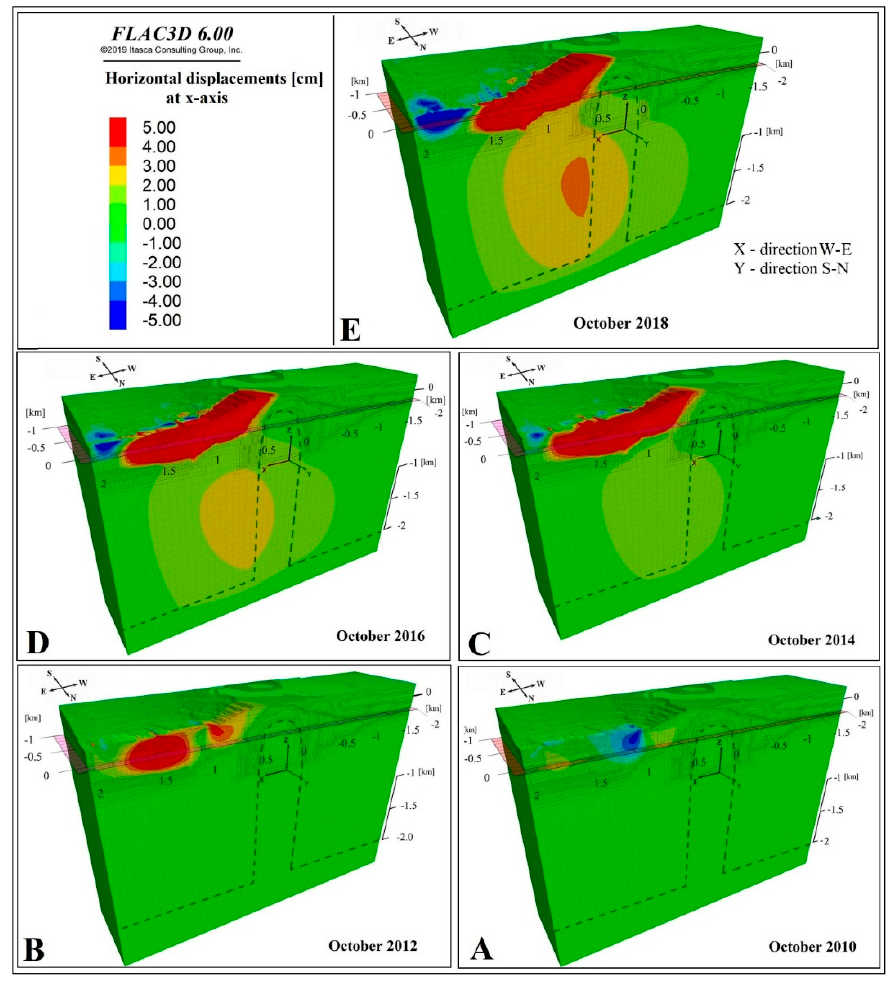
Figure 11. The horizontal displacements at the x -axis in the analyzed area: a positive value indicates movement towards the W; a negative value means movement towards the E.